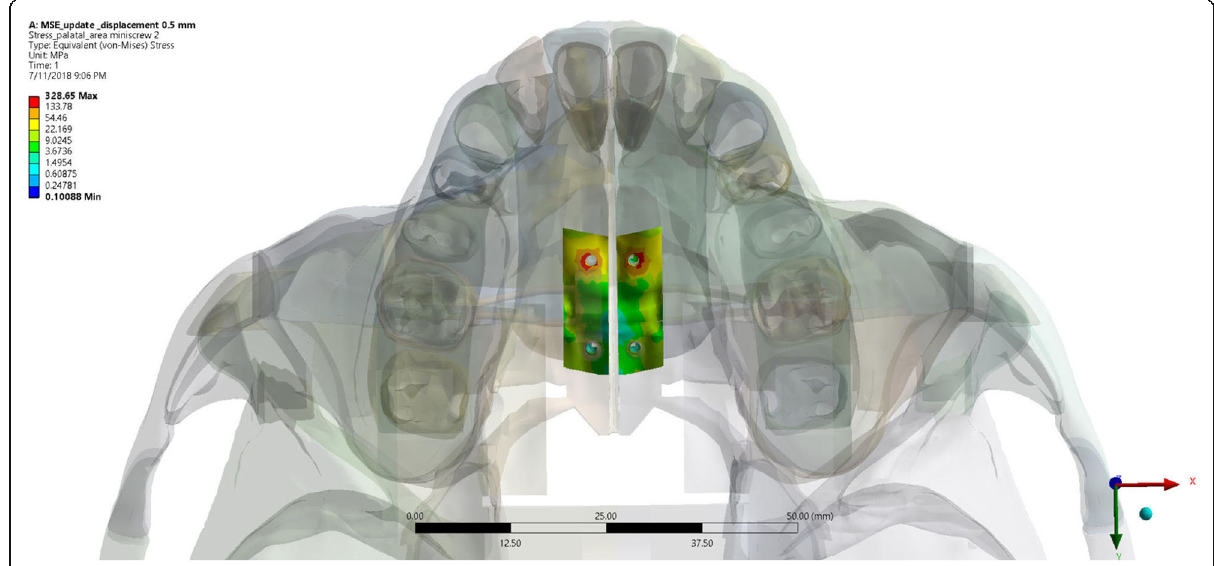
Fig. 6 The stress distribution of the palatal bone around miniscrew insertion site in the expansion simulation using MSE